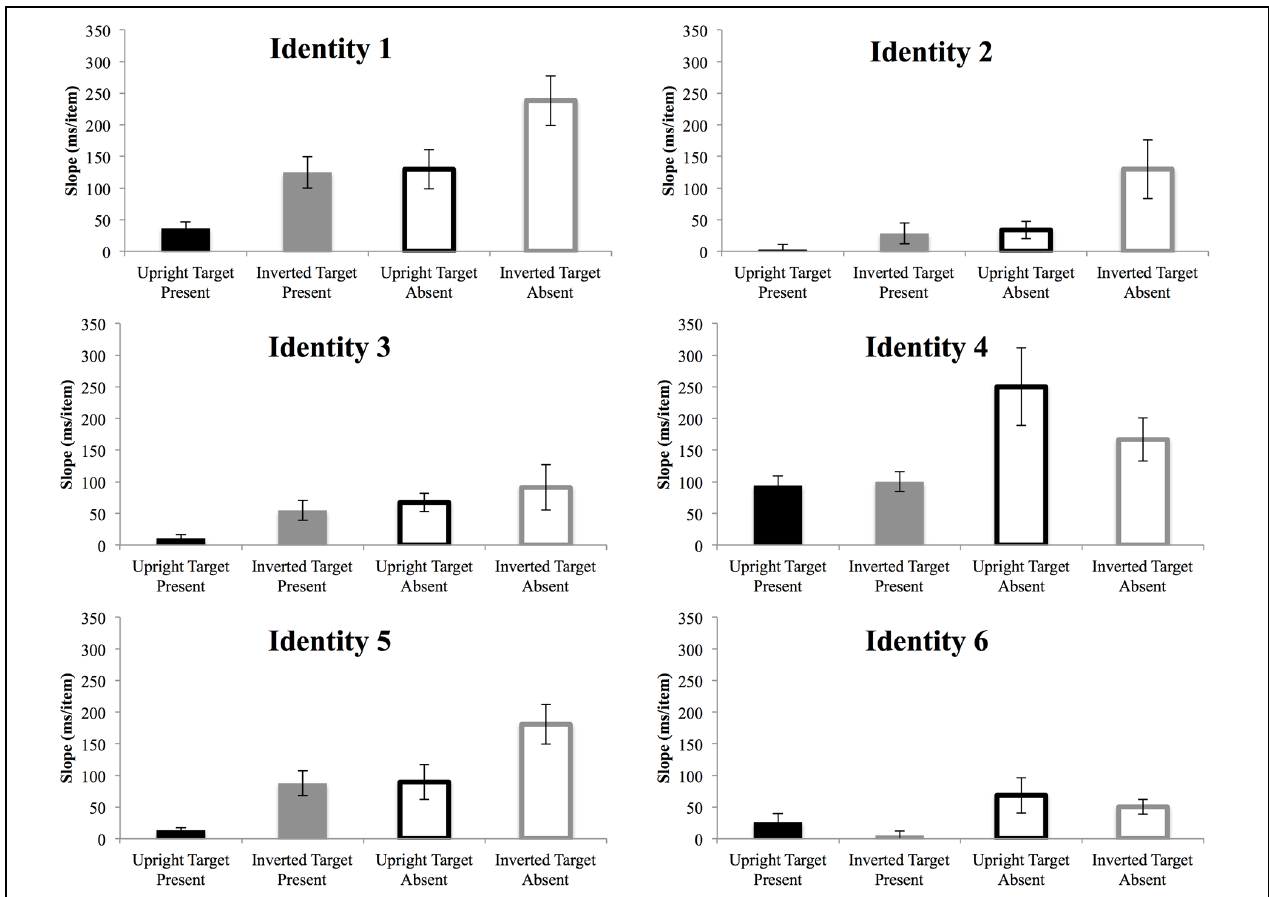
FIGURE 4 | Slopes of the reaction times as a function of search array set size for each target in Experiment 2. While the efficiency of search varies for each target, the main effect of inversion is evident in the majority of targets. Black bar, upright; gray bar, inverted; filled bar, target-present; hollow bar, target-absent. Error bars represent ± 1